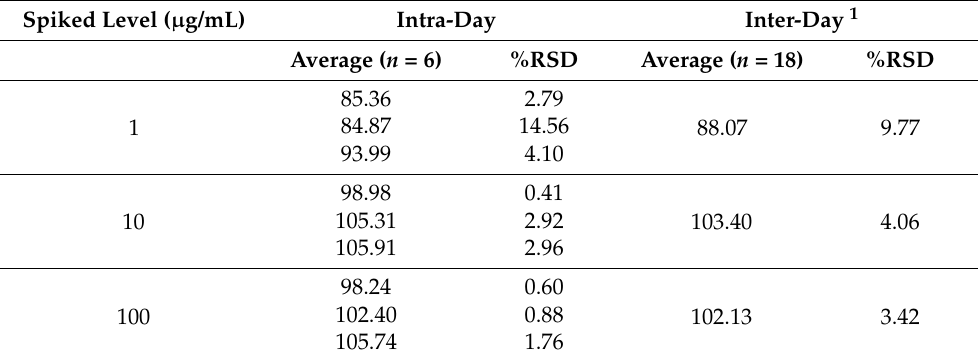
Table 2. Average recovery of metalaxyl in durian leaf for repeatability and reproducibility